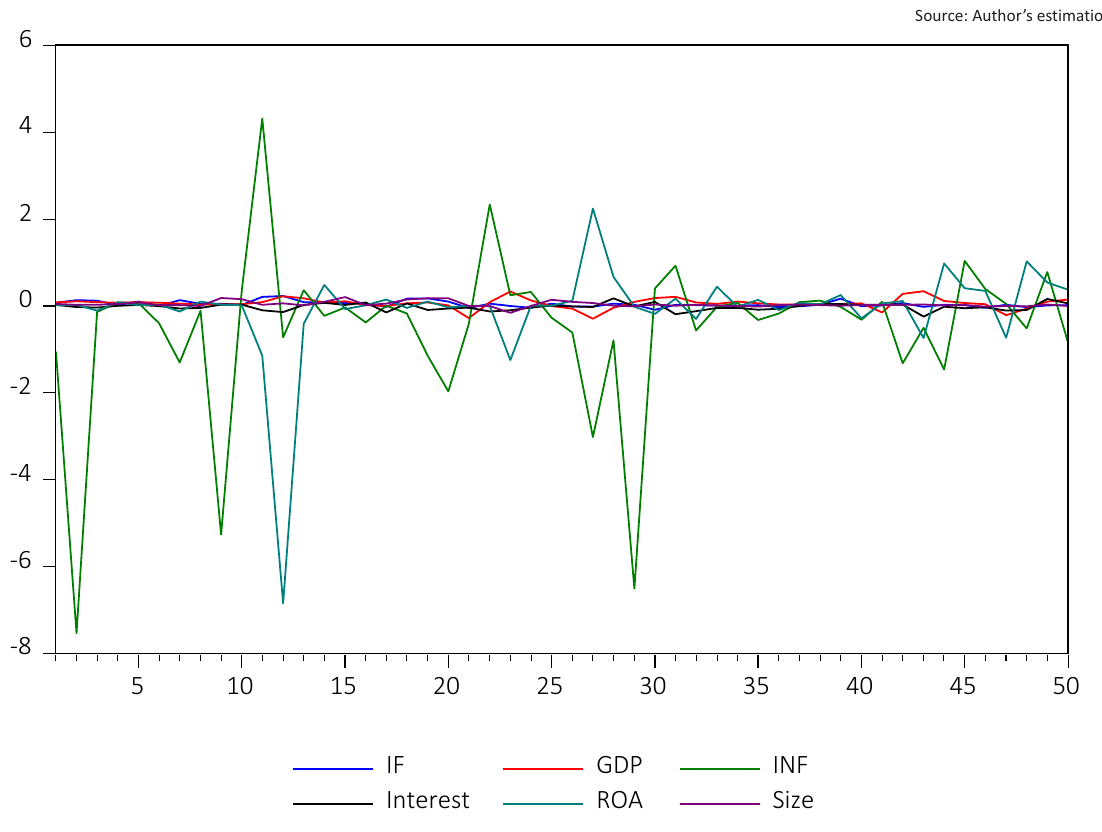
Figure 1. Co-integration